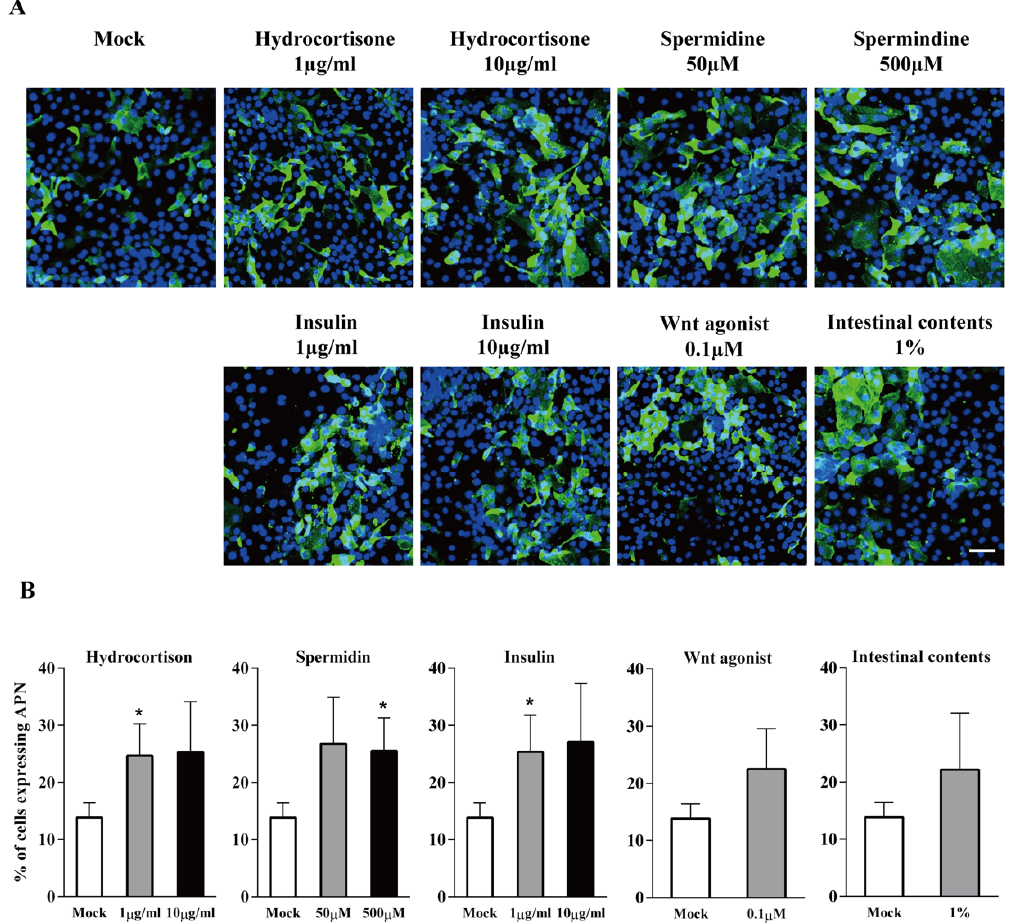
Figure 2. APN expression in primary ileum epithelial cells in the presence of enterocytes differentiation factors hydrocortisone, spermidine, porcine insulin, Wnt agonist, or small intestinal contents. ( A ) Immunofluorescence staining of APN expression (green) in enterocytes with different treatments. Scale bar: 50 µm. ( B ) The percentage of cells expressing APN at 24 h of treatment. Data are expressed as mean ± SD of the results of three separate experiments. Statistically significant differences in comparison with data from mock treatment are presented as * p < 0.05.